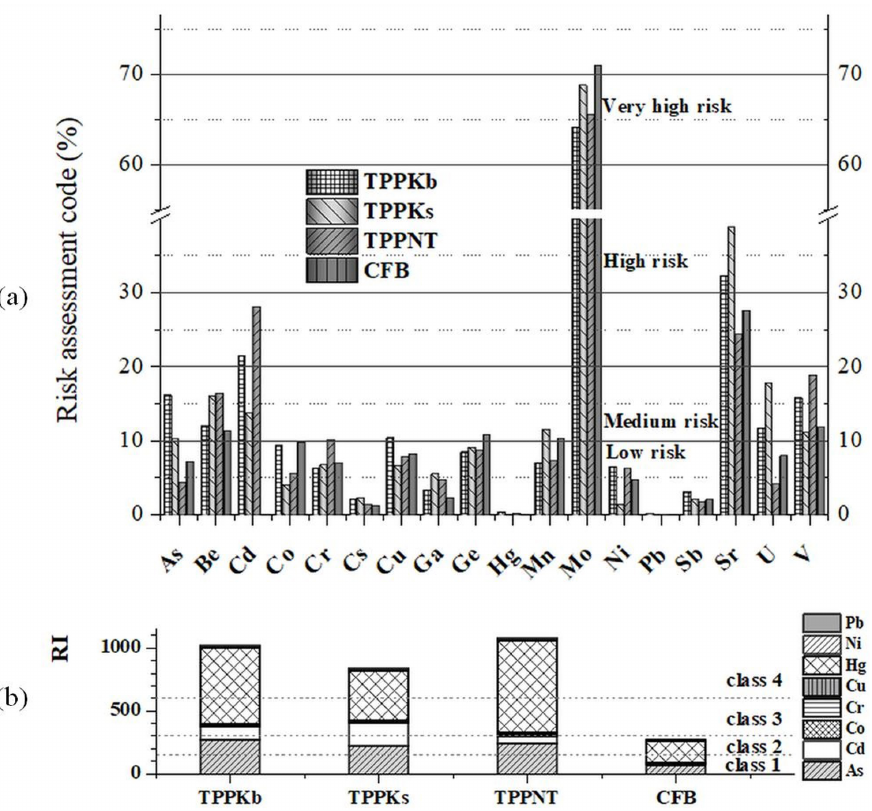
Figure 7. ( a ) Risk assessment code (RAC) and ( b ) risk index (RI) for fly ashes (TPPKb, TPPKs, TPPNT , and